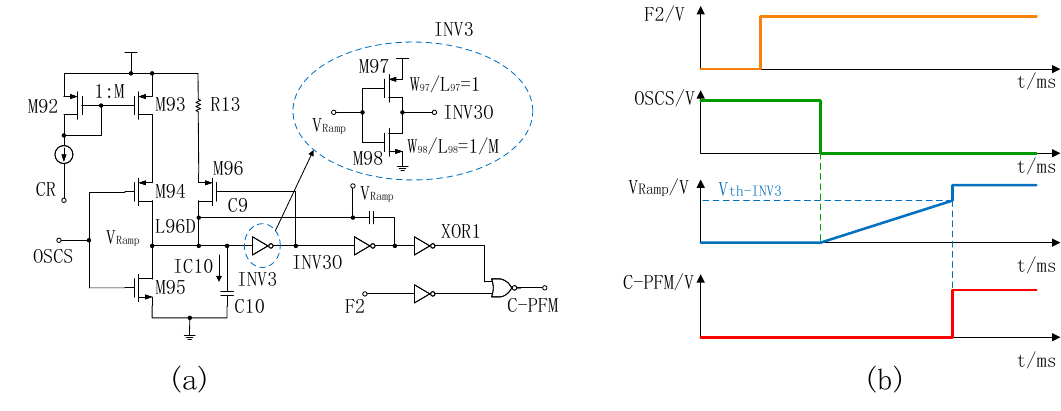
Figure 11. The circuit structure of the proposed V-Ramp-G and the timing relationships between the main signals. ( a ) The circuit structure of the proposed V-Ramp-G. ( b ) Main signal relationship in